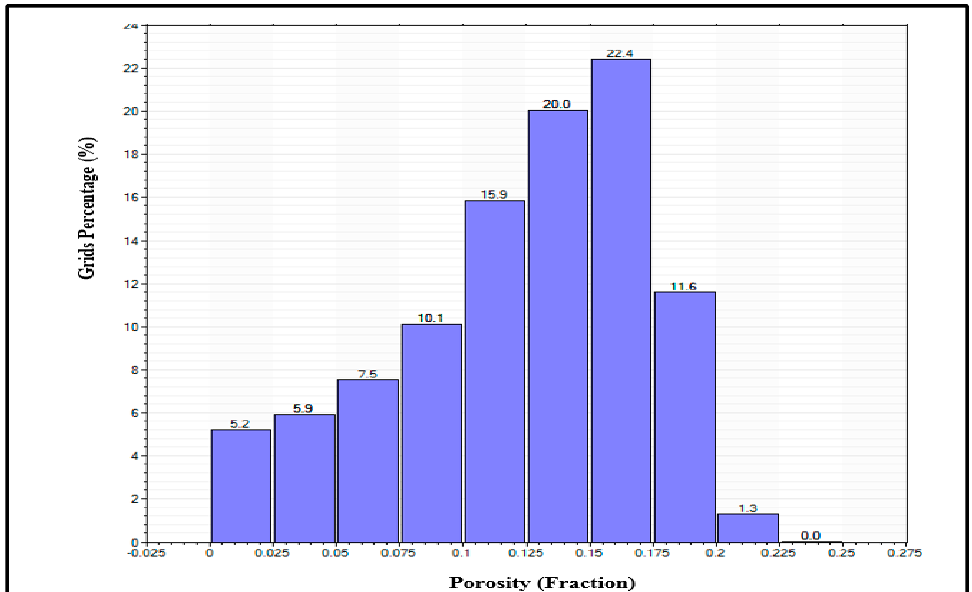
Figure 15. Porosity distribution histogram for the N Field sector reservoir model. Energies 2020 , 13 , x FOR PEER REVIEW